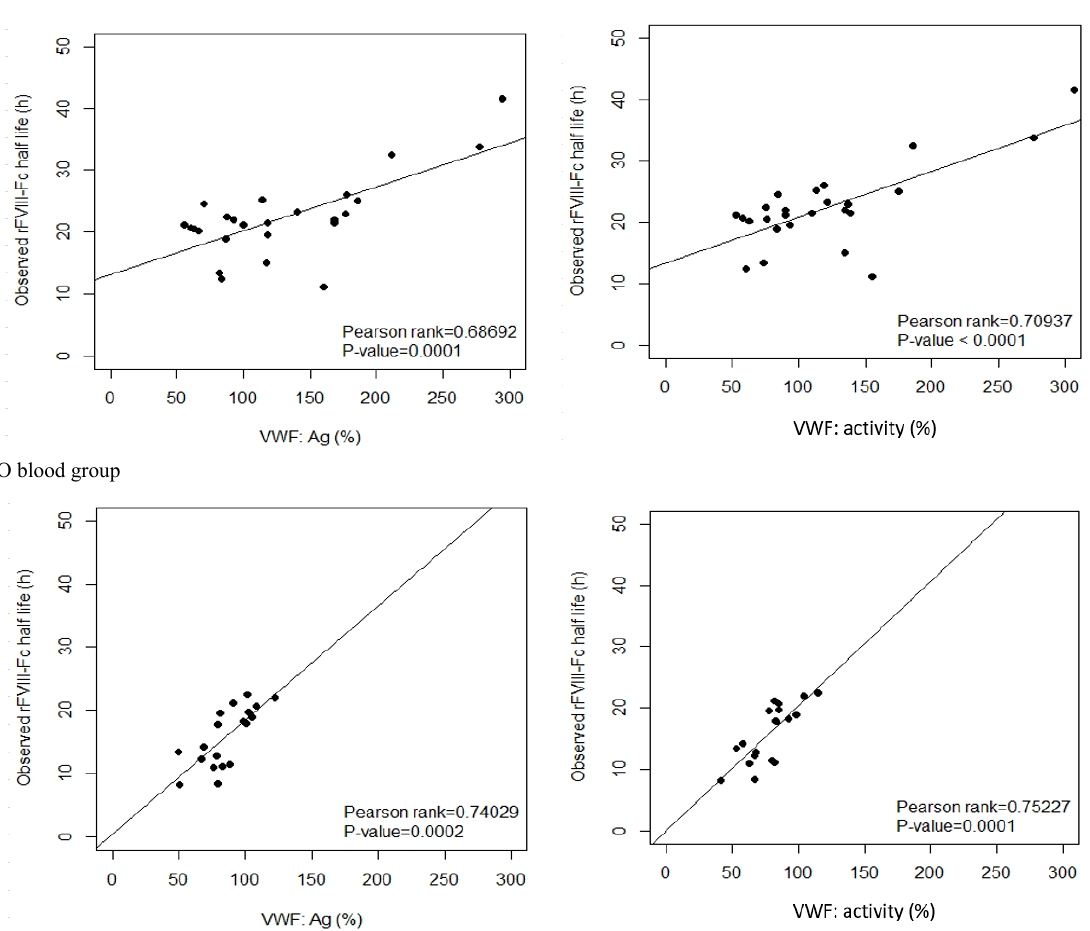
Figure 2. Clinical variables, including body weight (BW), body mass index (BMI), baseline VWF:Ag, and baseline VWF:activity, related to the observed rFVIII-Fc half life in the development cohort (n = 46). Both BW and BMI had a weak or moderate positive correlation to half life ( p -value < 0.01). Both baseline VWF:Ag and baseline VWF:activity had a strong positive correlation to half life ( p -value < 0.0001). The drawn lines show the best fit by univariate linear regression.